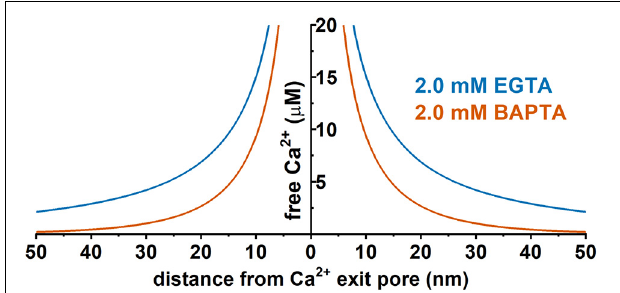
FIGURE 4 | Predicted distance dependence of the local free Ca 2 + concentration originating from a hypothetic Ca 2 + channel pore in the presence of 2 mM EGTA or 2 mM BAPTA. Prediction was performed using the CalC software (version 6.8.0) (Matveev et al., 2004) at 0.1 pA for the single-channel Ca 2 + current. Chelator and Ca 2 + parameters were taken from previous reports (Naraghi and Neher, 1997; Fakler and Adelman, 2008; Eggermann et al., 2011).